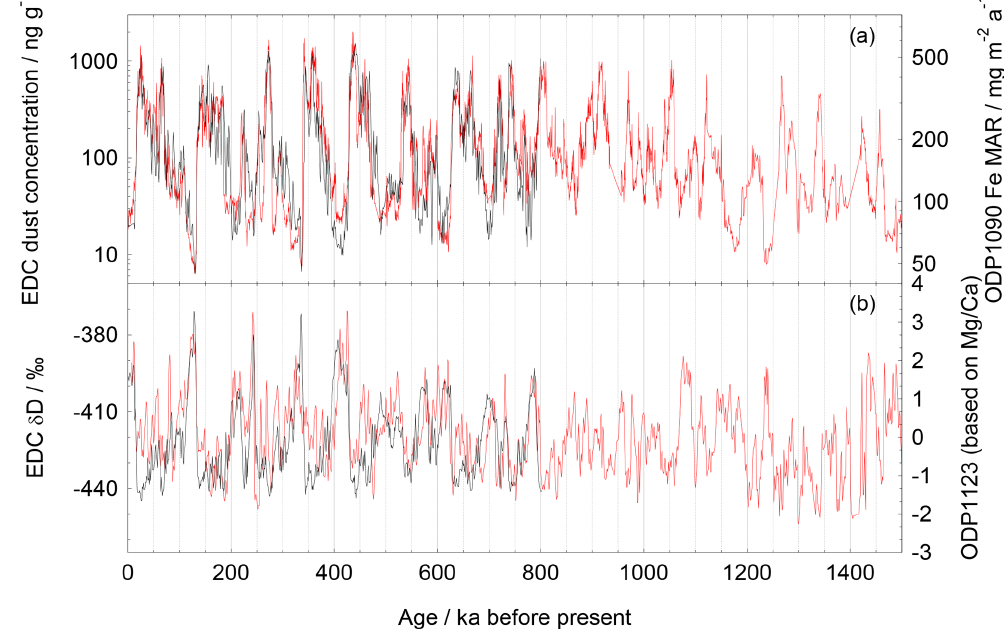
Figure 4. Ice core records to 800ka and marine records to 1500ka. (a) EDC dust (black) (Lambert et al., 2008) and Fe MAR from ODP site 1090 (red) (Martinez-Garcia et al., 2011). (b) EDC deuterium (black) (Jouzel et al., 2007) and Mg / Ca-based deepwater temperature (red) from site ODP1123 (Elderfield et al.,